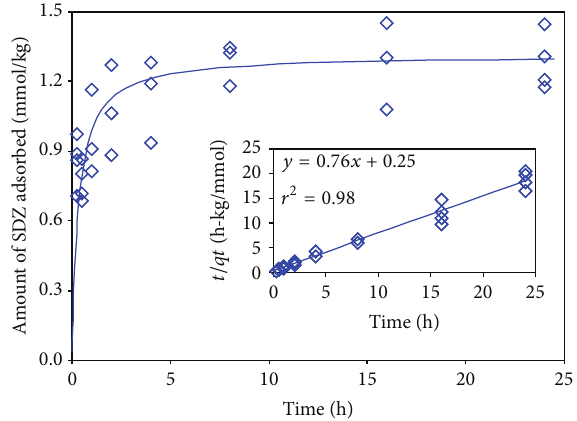
Figure 2: Kinetic study of SDZ adsorption on zeolite. The line is the pseudo-second-orderfittotheobserveddataandtheinsetistheplot of (2).